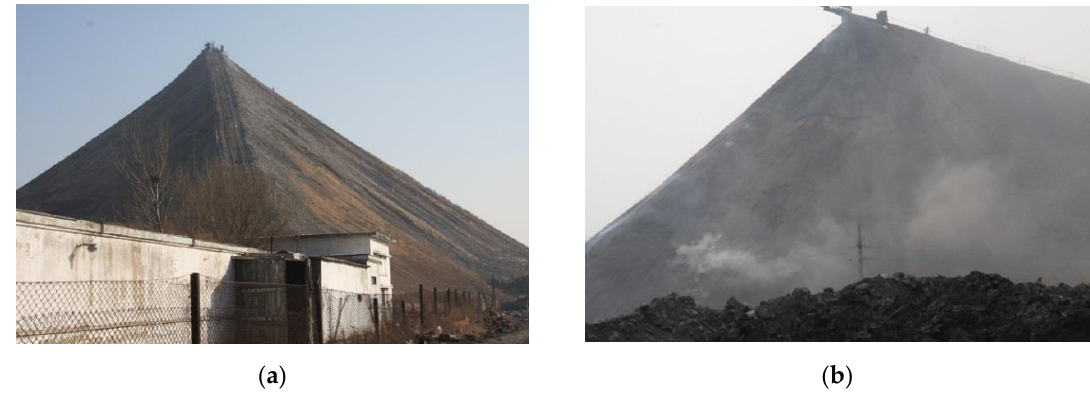
Figure 1. Photo of coal gangue dumps being used in the Tiefa mining area. ( a ) Unburned coal gangue dump, ( b ) burned coal gangue dump.